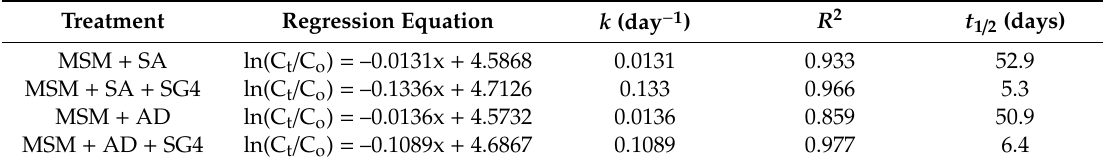
Initial cypermethrin concentration was 50 mg · L − 1 . A linear equation was derived from chemical data of C 0 and C t , to calculate k , R 2 , and t 1 / 2 values. SA: sodium alginate; AD: agar discs.